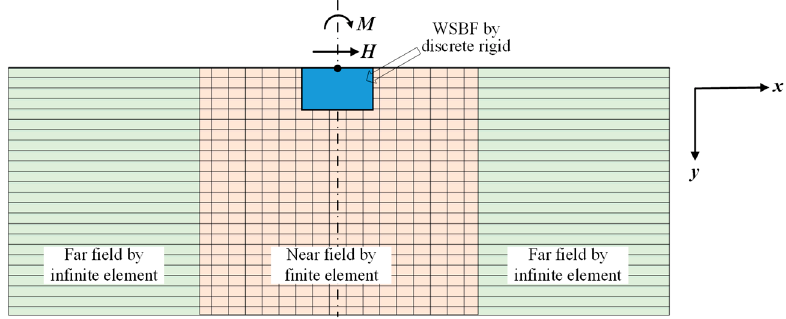
Figure 4. Two-dimensional coupling numerical model of WSBF in the finite and infinite element domains.